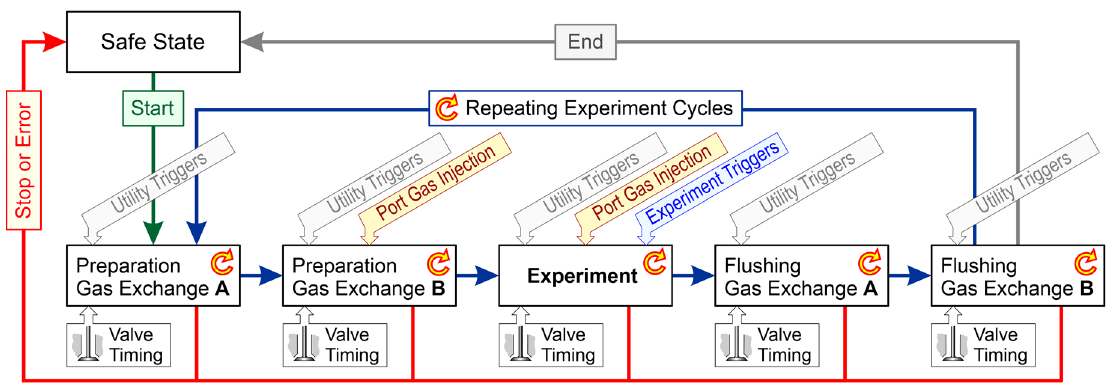
Figure 8. Basic structure of experiment cycles in the Figure 8: Basic structure of experiment cycles in the Flex-OeCoS.